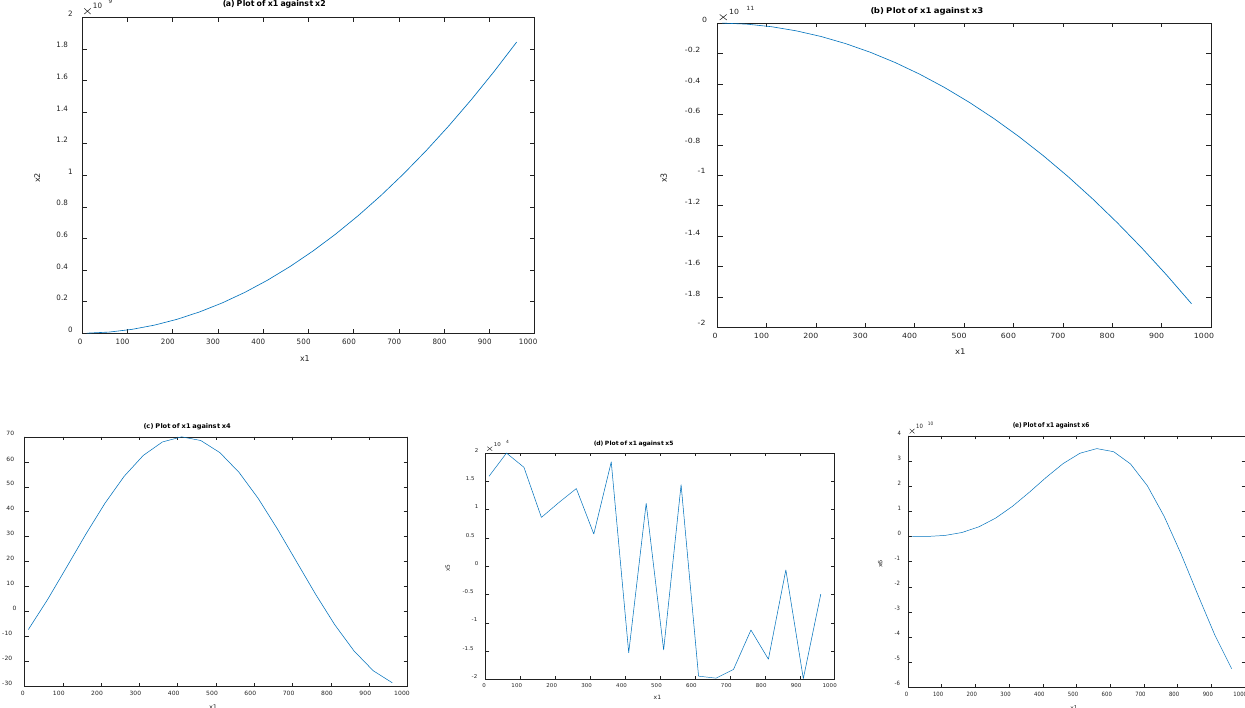
Figure 3. Simulation of the CB model of SoTE for x 1 = 1:5:100. ( a )input quadratic function, ( b ) input quadratic function, ( c ) resultant polynomial function, ( d ) induced interference ( e ) output wave function.